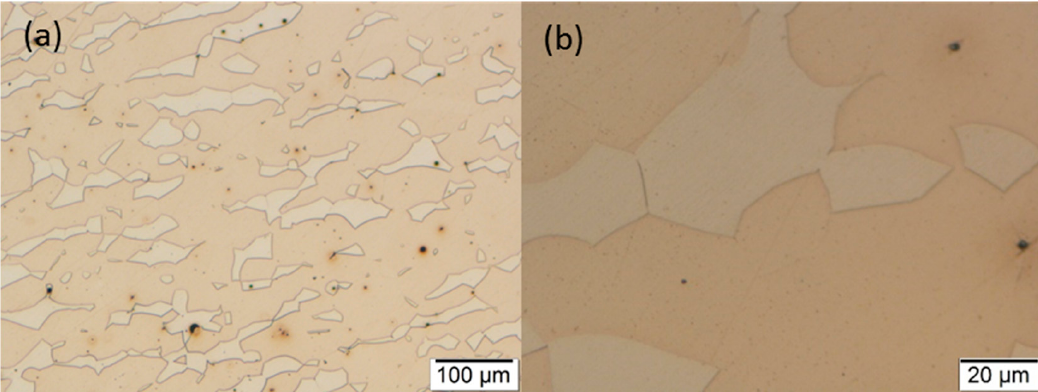
Figure 5. Optical microscopy of the sample that was isothermally annealed at 350 °C, etched with 10% nital, ( a ) ferrite–– white, and austenite––brown, ( b ) magnified detail, there is possible precipitation on the grain boundaries.